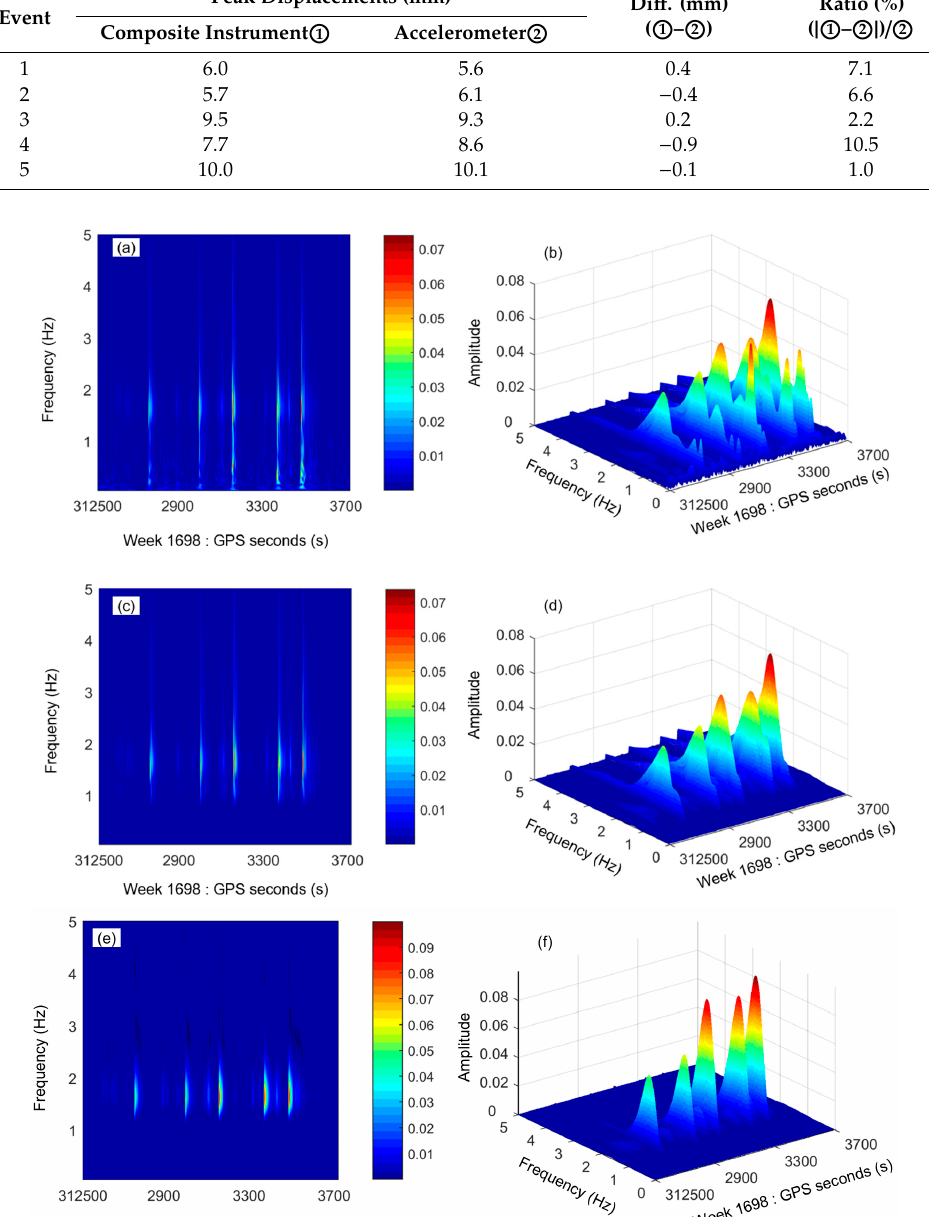
Figure 7. Wavelet-based spectra of the displacement time series in the vertical direction: two- and three-dimensional spectra of overall vibration displacements ( a , b ) and dynamic displacements ( c , d ) derived from the composite instrument data, and dynamic displacements ( e , f ) derived from the accelerometer data. The horizontal axis indicates the GPS time, which is composed of GPS weeks and week seconds. The color pattern indicates the amplitudes of the energy spectrum that are dimensionless.